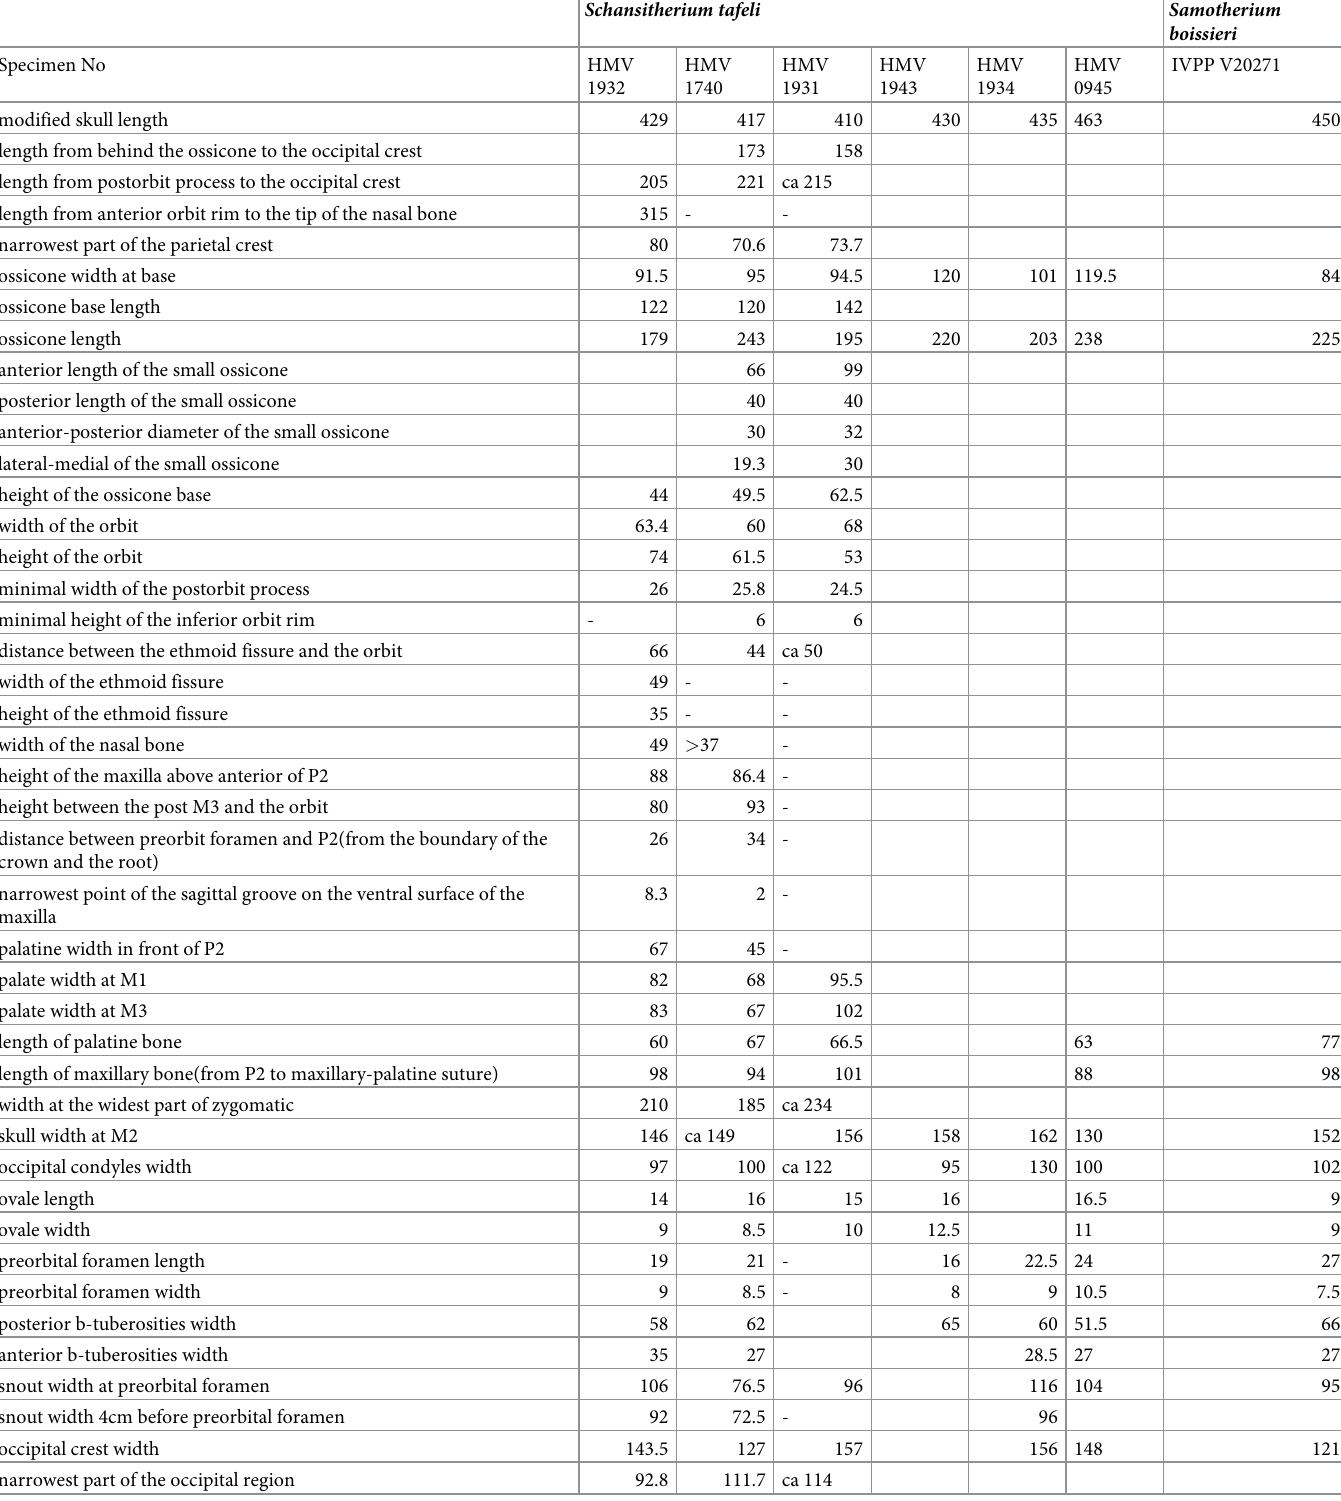
Table 2. Measurements of Schansitherium and Samotherium